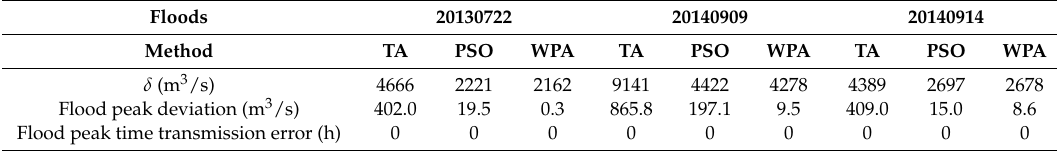
Table 9. Analysis of Ankang hydropower station–Shuhe hydropower station simulation